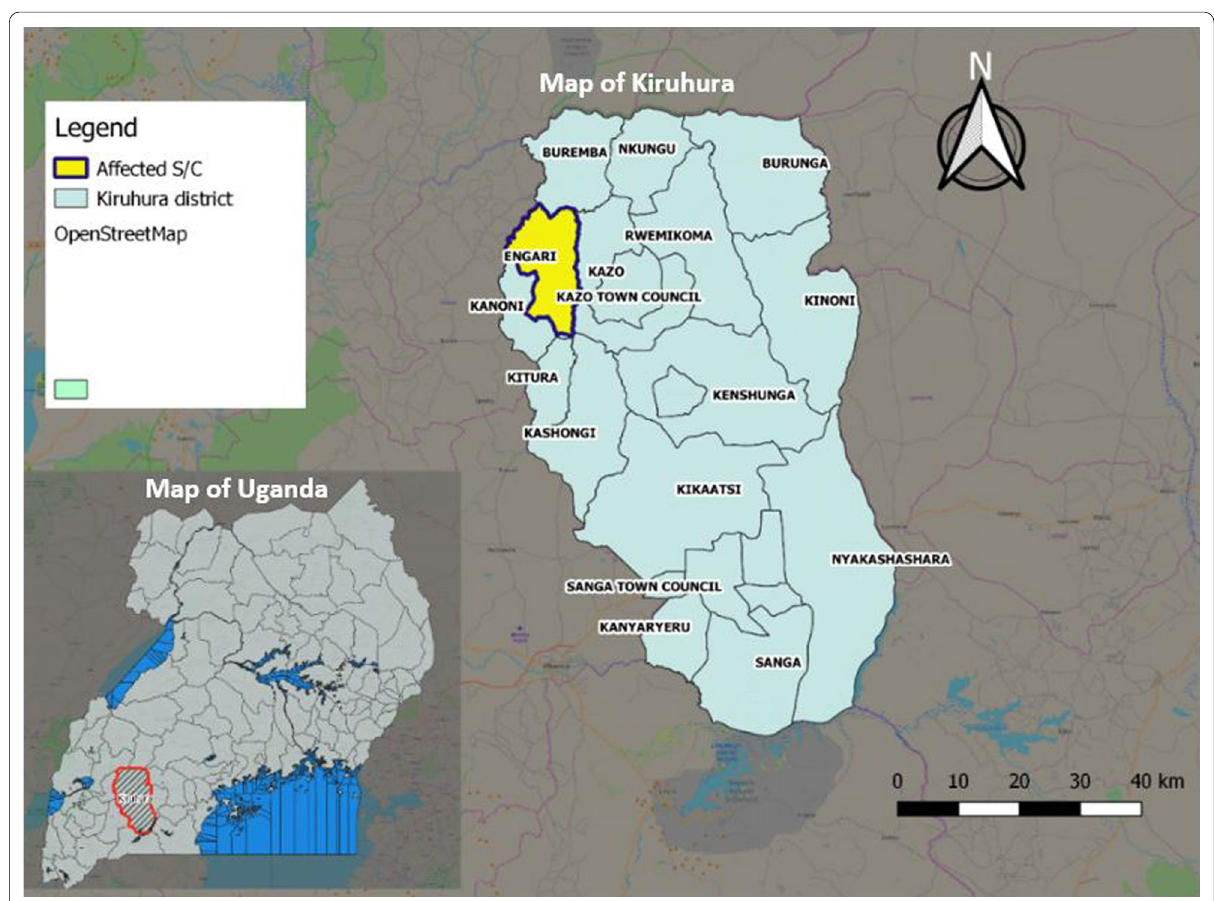
Fig. 1 Showing the affected sub‑county in Kiruhura District, May